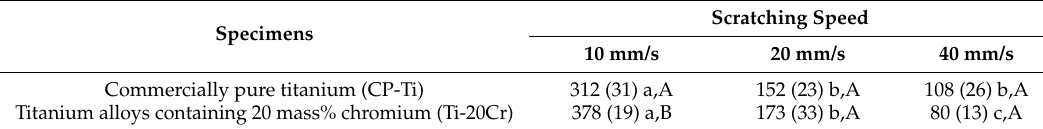
Table 1. Mean (standard deviation) of repassivation times (T re ; ms) from the last scratching cycle for both commercially pure titanium (CP-Ti) and titanium alloys containing 20 mass% chromium (Ti-20Cr) at different scratching speeds.